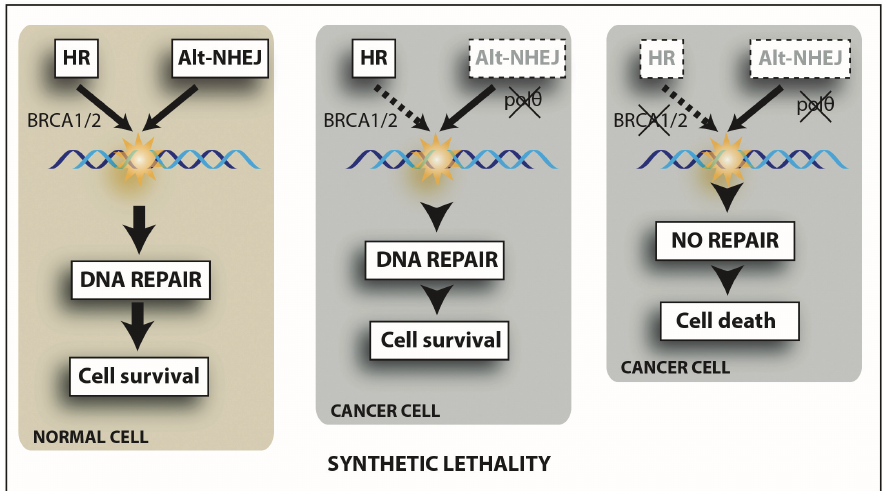
Figure 4. The synthetic lethality pathway model based on a deficiency in Alt-NHEJ and the double-strand break repair